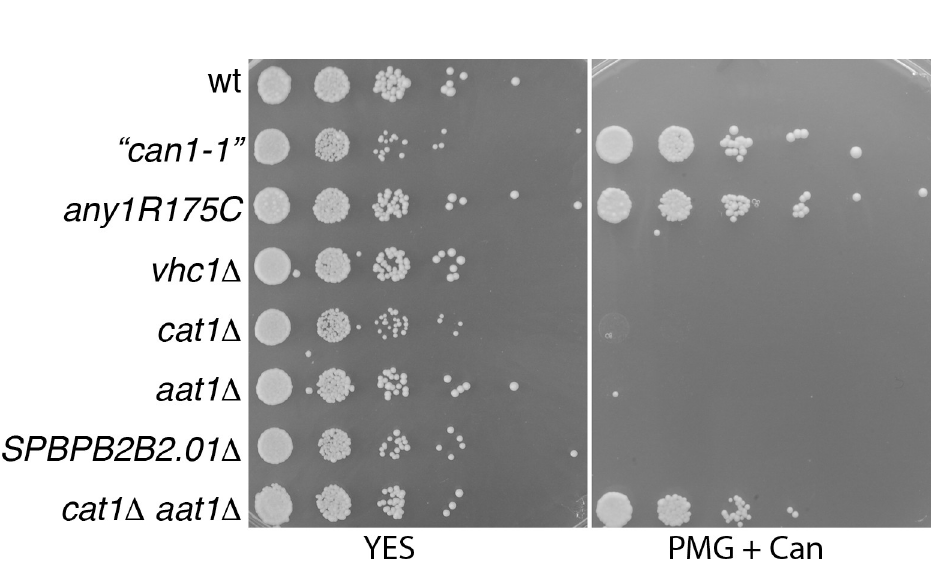
Fig 3. Comparison of canavanine-resistance phenotype of strains mutated in transmembrane transporters and vhc1 + . Serial (1/10) dilutions of strains were spotted on the YES and PMG+canavanine plates (80 μ g/ml) and incubated at 30˚C for 2–5 days. Strains used were: 2299 (wt); 3647 ( can1-1 ); 4089 ( any1R175C ); 3791 ( vhc1 Δ ); 4059 ( cat1 Δ ); 3790 ( aat1 Δ ); 3796 ( SPBPB2B2 . 01 Δ );3797 ( aat1 Δ cat1 Δ )